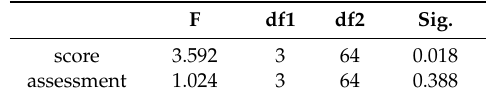
Table 9. Results of Levene’s test for equality of variances (type of e-Learning activities). F df1 df2 Sig.